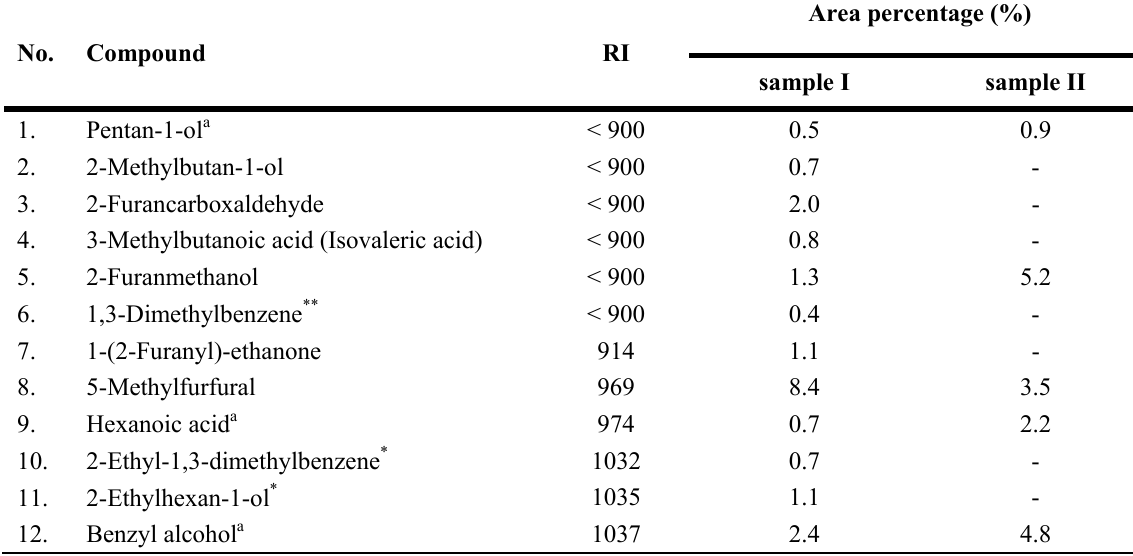
Table 1. Oak honeydew organic headspace volatiles composition isolated by